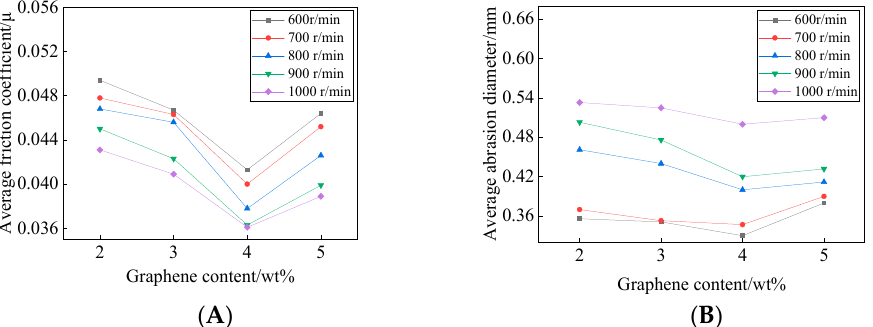
Figure 10. The relationship between the frictional properties of the EJC and the MEG. ( A ) Average